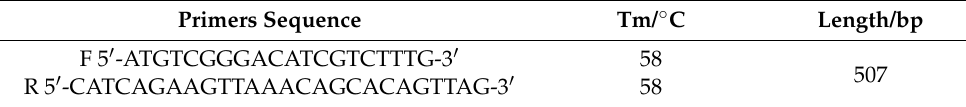
Table 1. The sequence and length of primers for ASMT gene PCR